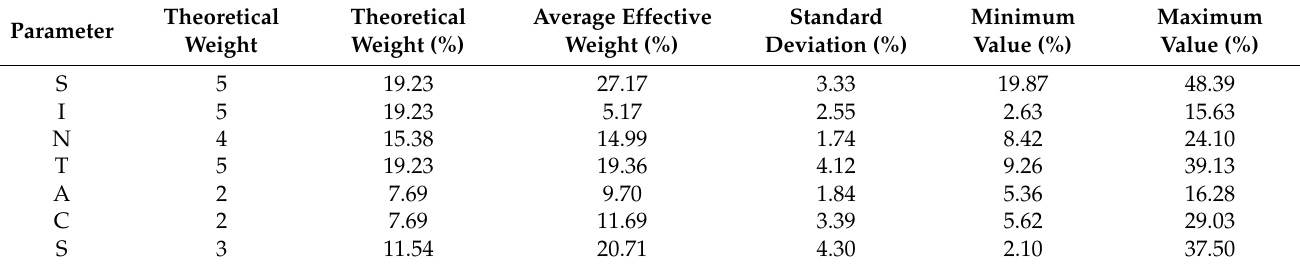
Table 5. Statistical summary of the SINTACS single-parameter sensitivity